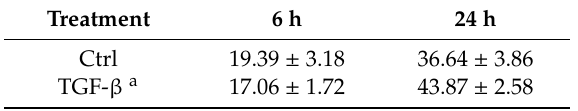
Table 3. Wound healing percentage of untreated and TGF- β -stimulated HaCaT cells.